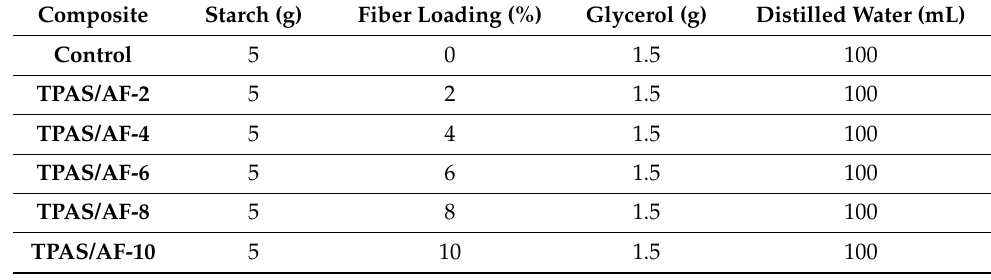
Table 1. A composite formulation for control and TPAS/AF composites.